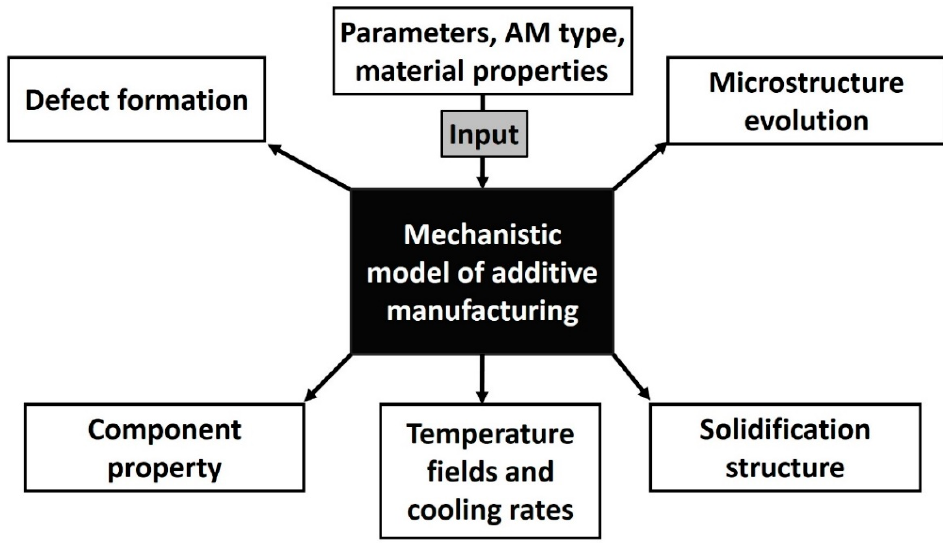
Figure 5. Mechanistic model of 3D printing to predict the results.